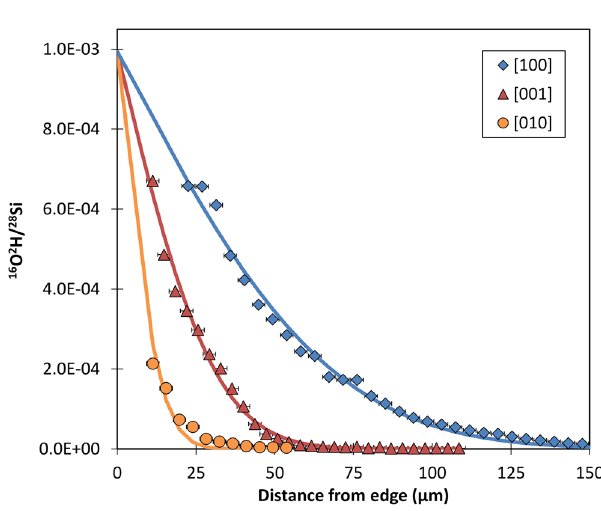
Figure 2. Deuterium diffusion profiles (plotted as 16 O 2 H − / 28 Si − , which is directly proportional to deuterium concentration in olivine) as a function of distance normal to faces oriented along [100] (blue diamonds), [001] (red triangles) and [010] (yellow circles), with lines showing fits (equation 1, see text). Data are for experiment PC25 (2 GPa, 750 °C). Average background 16 O 2 H − / 28 Si − values were monitored to be 10 − 5 –10 − 6 by measuring nominally anhydrous San Carlos olivine, considered to be a blank for 2 H. Diffusion profiles along all principal orientations were observed to decrease to background noise values at approximately 150, 60 and 30 µ m for this experiment, depending on